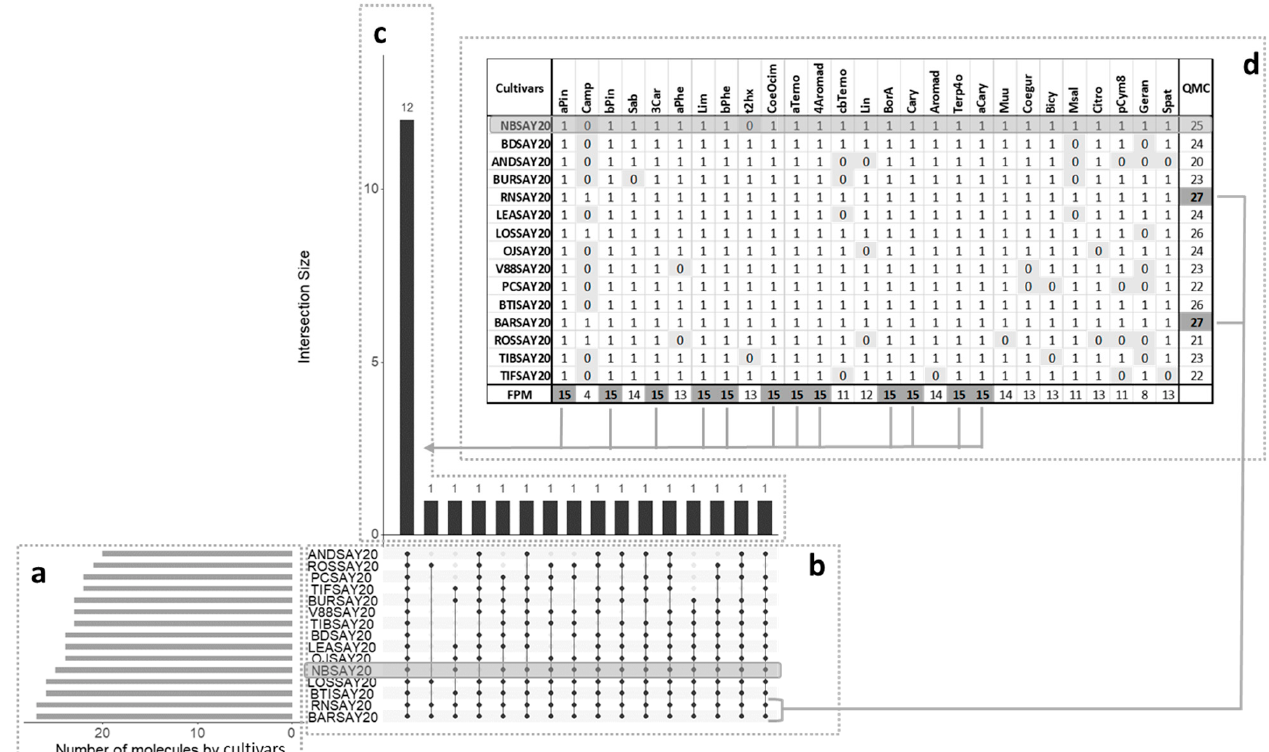
Figure 2. UpSet plot showing co-occurrence of volatile molecules in the various cultivars. QMC: Quantity of molecules found in each cultivar. The total size of each set is represented on the left barplot ( a ). Every possible intersection is represented by the bottom plot ( b ), and their occurrence is shown on the top barplot ( c ). ( d ) Detailed table with frequency of presence of molecules (FPM) in cultivars; presence is indicated by 1 and absence by 0.